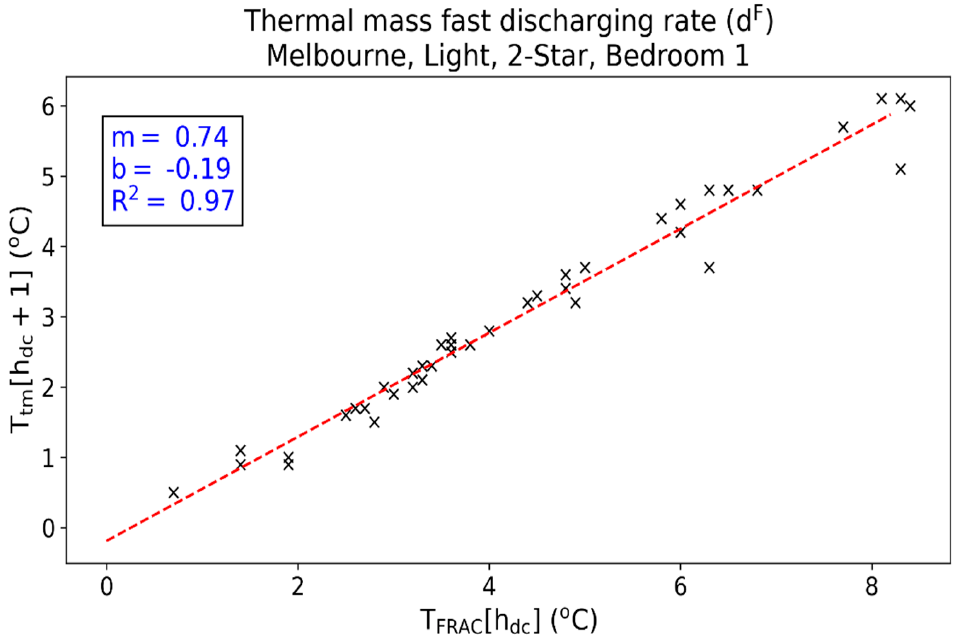
Figure 4. Scatter plot of T FRAC [ h dc ] versus T tm [ h dc + 1], defining the thermal mass fast charging rate d F , for Bedroom 1 in template home